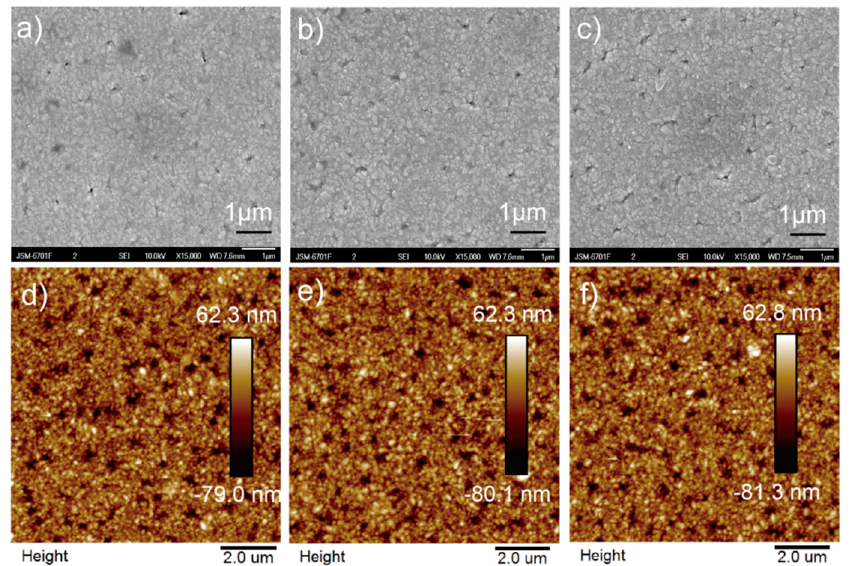
Figure 6. SEM images of ( a ) Sc 3 N@C 78 ⊂ [12]CPP, ( b ) Sc 3 N@C 80 ⊂ [12]CPP, and ( c ) Sc 2 C 2 @C 82 ⊂ [12]CPP complexes after spin coating on FTO glass, respectively. AFM images of ( d ) Sc 3 N@C 78 ⊂ [12]CPP, ( e ) Sc 3 N@C 80 ⊂ [12]CPP, and ( f ) Sc 2 C 2 @C 82 ⊂ [12]CPP complexes after spin coating on FTO glass, respec- tively.